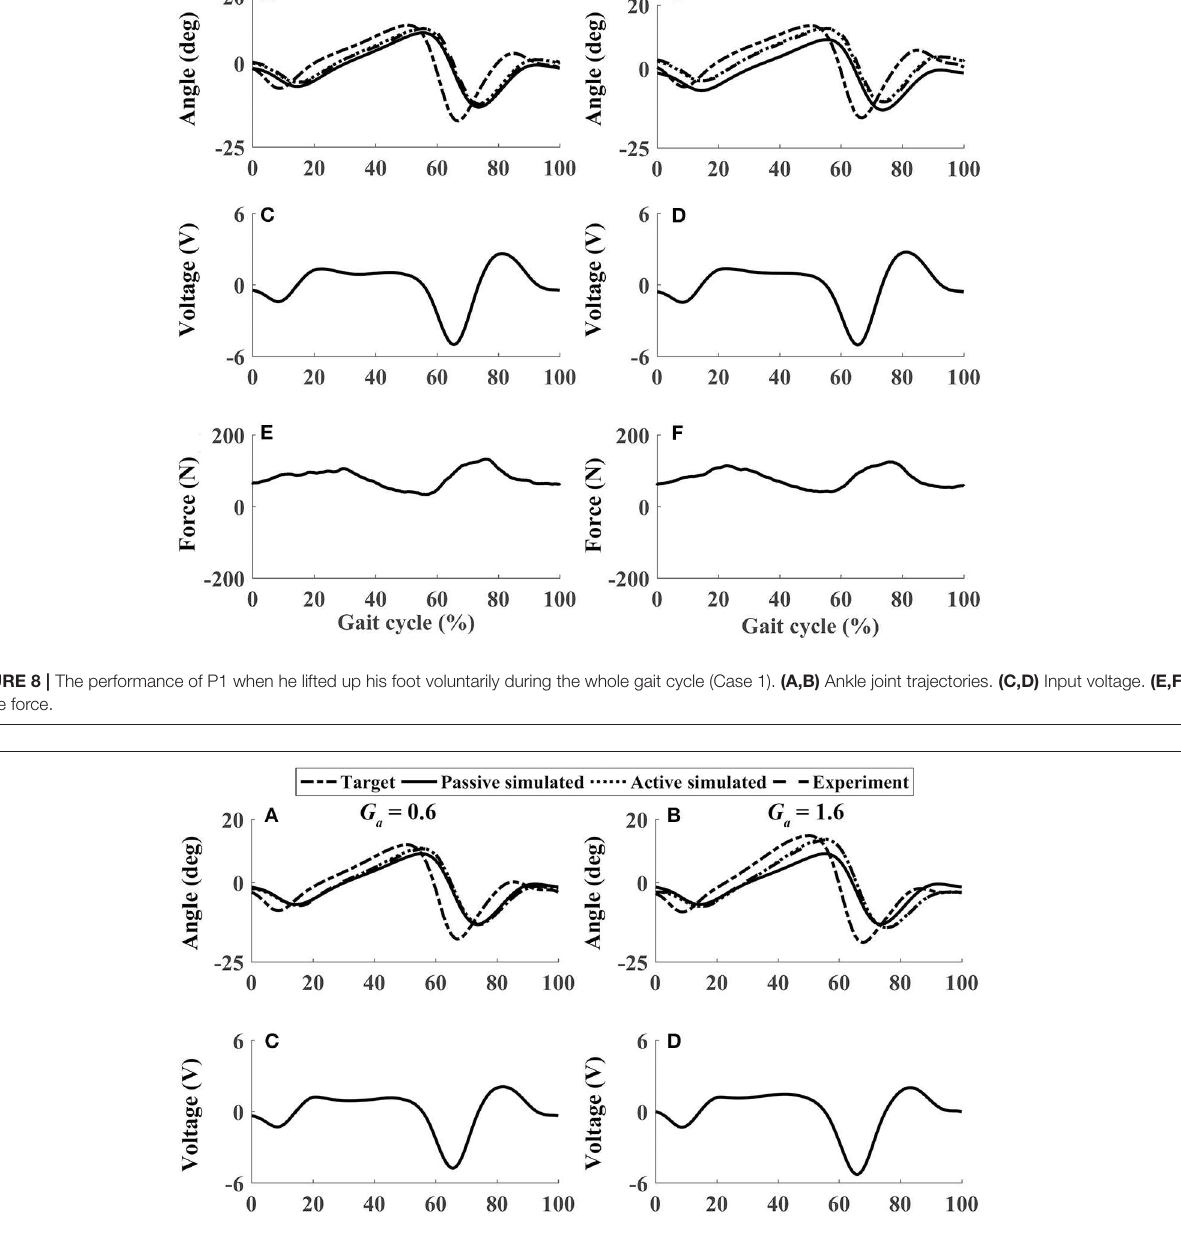
Frontiers in Neurorobotics | www.frontiersin.org